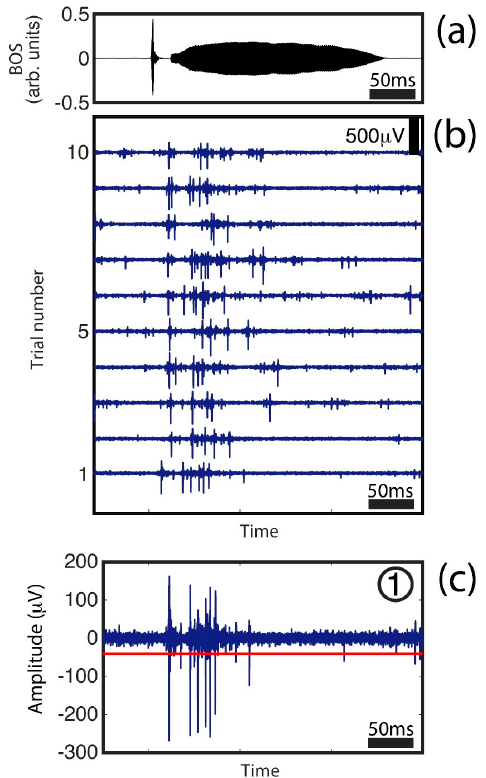
Figure 2. Raw data thresholding and multiunit activity (MUA). ( a ) BOS sound segment (single canary song syllable). ( b ) High-pass filtered raw data traces of the neural response to auditory presentations